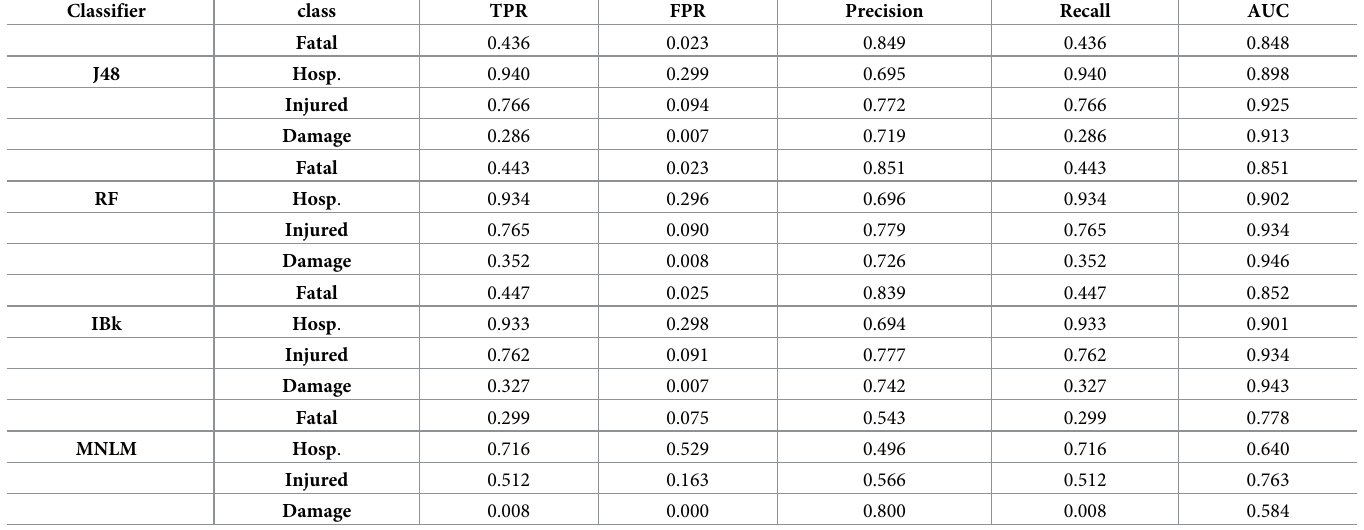
Table 4. Comparison of performance metrics by class for each